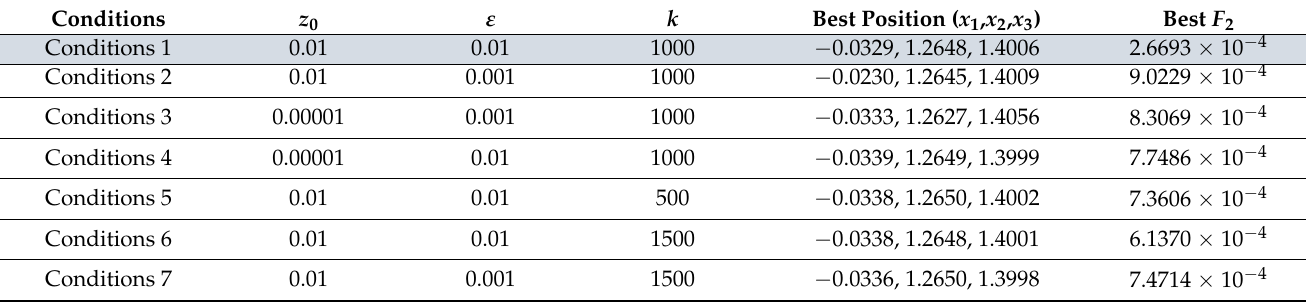
Table 5. Results of Case 2: F 2 at different conditions.